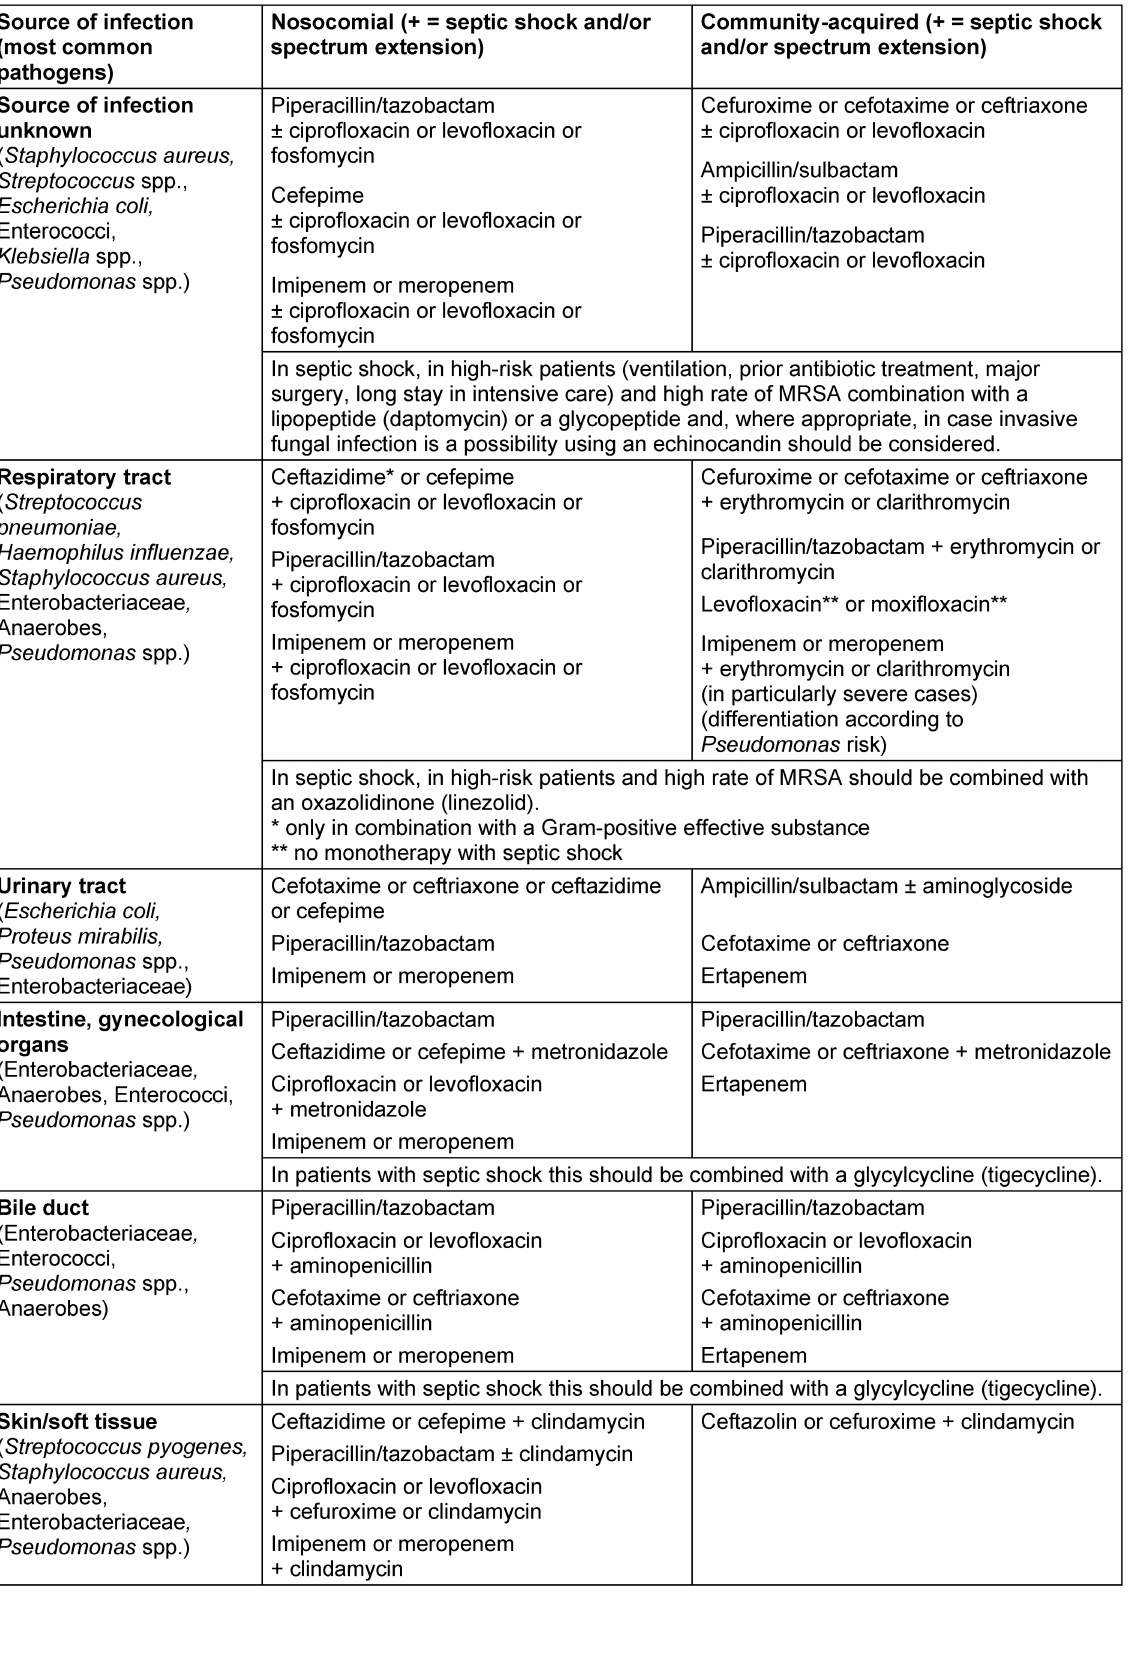
Table 1: Recommendations for the treatment of sepsis with unknown pathogen. (Treatment recommendations are not intended for immunosuppressed and neutropenic